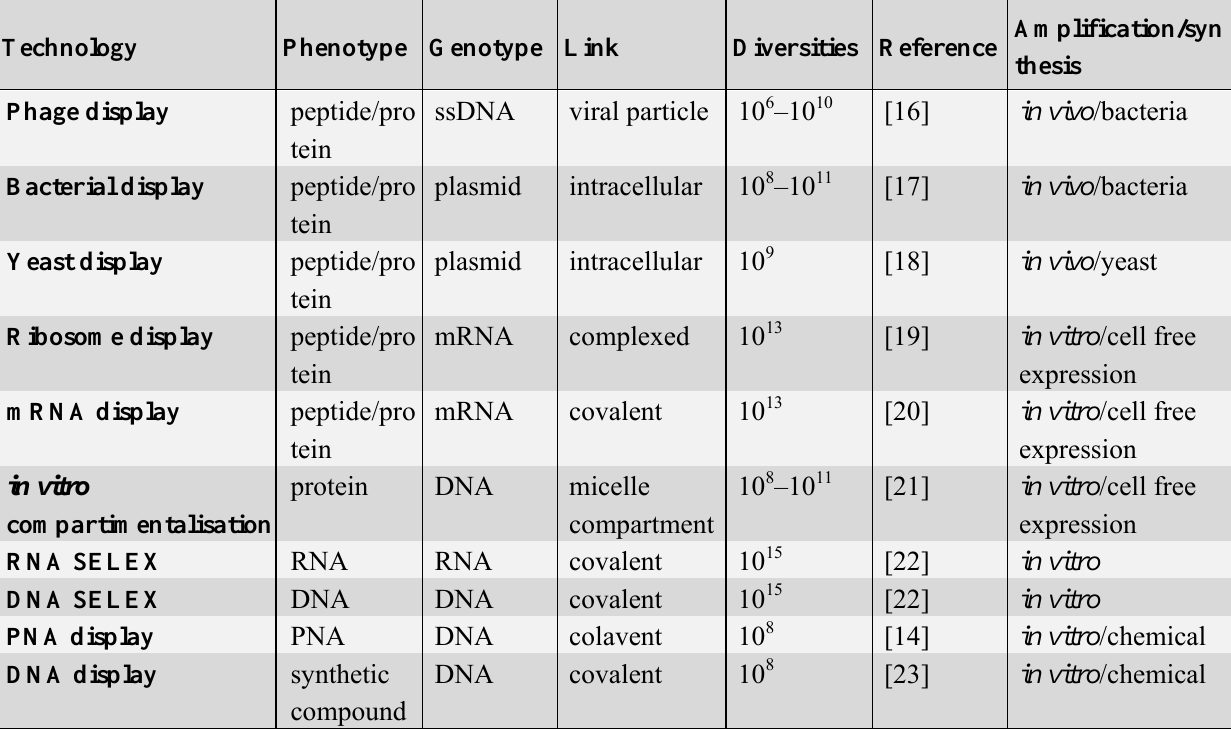
Table 1. A selection of random combinatorial libraries technologies based on the concept of phenotype and genotype